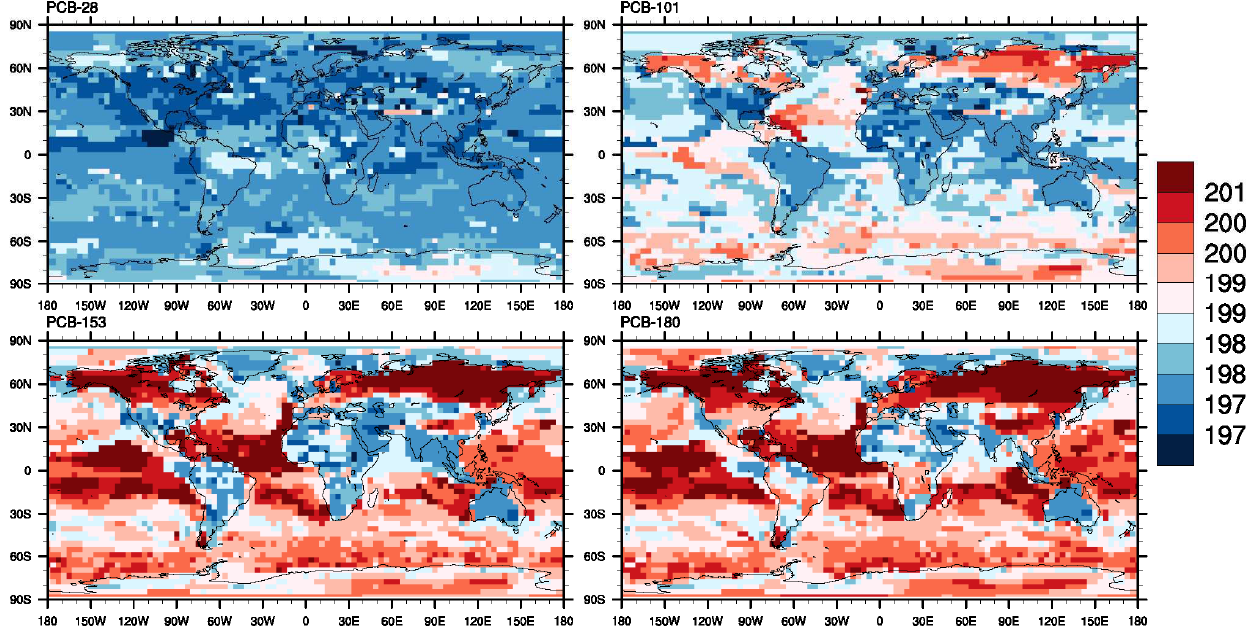
Fig. 8. Mapped year of peak total environmental burden. Identical emission distributions used (historic only for PCB153, see text).